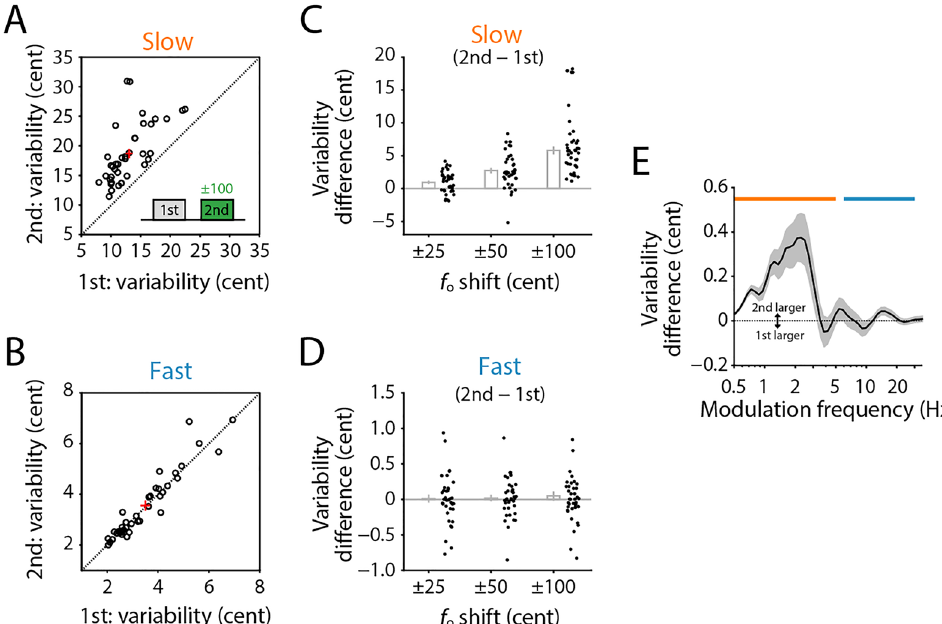
Figure 3. Variability comparison between the first (no f o shifts) and second ( f o shifted) vocalization. ( A , B ) Mean variability of the slow ( A ), and fast fluctuation ( B ) components in ± 100-cent shift conditions of the second vocalization compared to the first vocalization. Red crosshair indicates the mean and standard error. ( C , D ) Variability difference of the slow ( C ) and fast ( D ) components in ± 25-, ± 50-, and ± 100-cent shift conditions between the second and first vocalizations. Errorbar indicates the standard error among 38 participants. ( E ) Variability difference of each sub-band component obtained by the modulation filter bank in ± 100-cent shift conditions between the second and the first vocalizations. Gray area indicates the standard error.